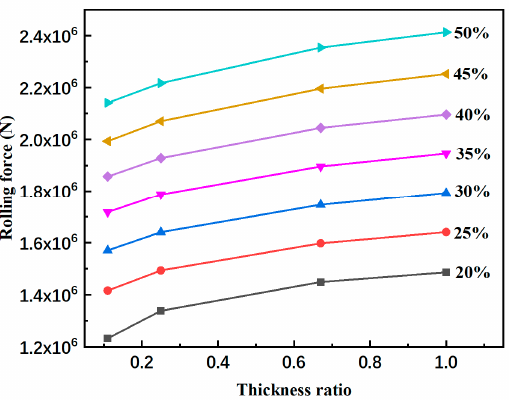
Figure 9. Changes in rolling force vs. thickness ratio of the clad plate. The rolling speed ratio is one of the most important parameters that affect the rolling force in the hot rolling process. Figure 10 shows the relationship between the rolling speed ratios and the variations of the rolling forces. It should be noted that the above studies were carried out at four different total reduction ratios, i.e., 20%, 30%, 40% and 50%. The simulation results are shown in Figure 10.